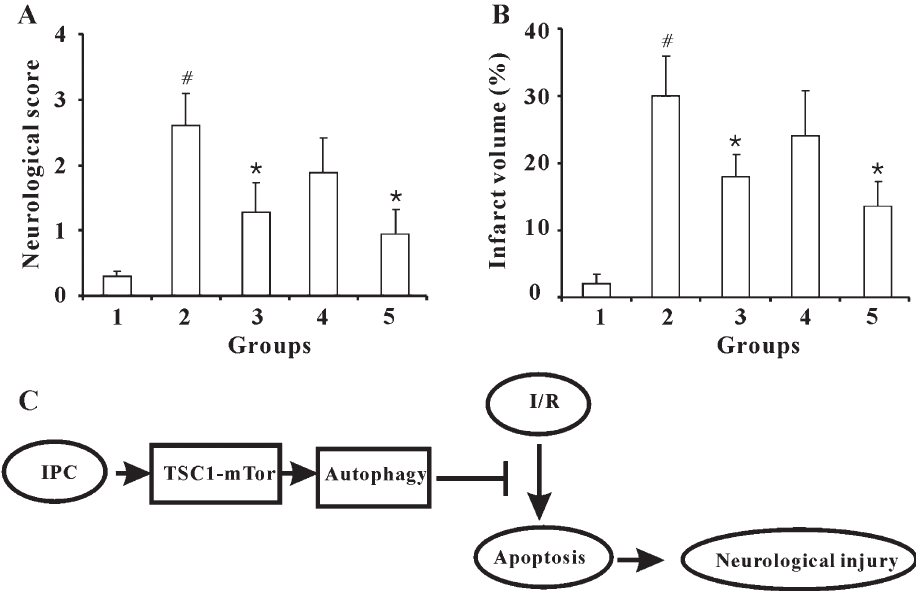
Figure 6. Ischemic preconditioning (IPC) protects against ischemic reperfusion (I/R)-induced neurological damage 24 h post-ischemic injury. A , IPC attenuates I/R-induced increase in neurological score. B , IPC attenuates I/R-induced increase in infarct volume. Data are reported as means±SE of 4 rats in each group. Groups: 1) sham control, 2) I/R, 3) 5 6 5 6 5 min IPC++I/R, 4) 3- methyladenine++5 6 5 6 5 min IPC++I/R, and 5) rapamycin++5 6 5 6 5 min IPC++I/R. # P , 0.05, compared to sham control group; *P , 0.05, compared to I/R group (one-way ANOVA followed by the Bonferroni test). C , Scheme illustrates the possible protective mechanisms of IPC against ischemic injury through tuberous sclerosis type 1 (TSC1)-mTor-mediated autophagic activation, which inhibited apoptosis induced by ischemic